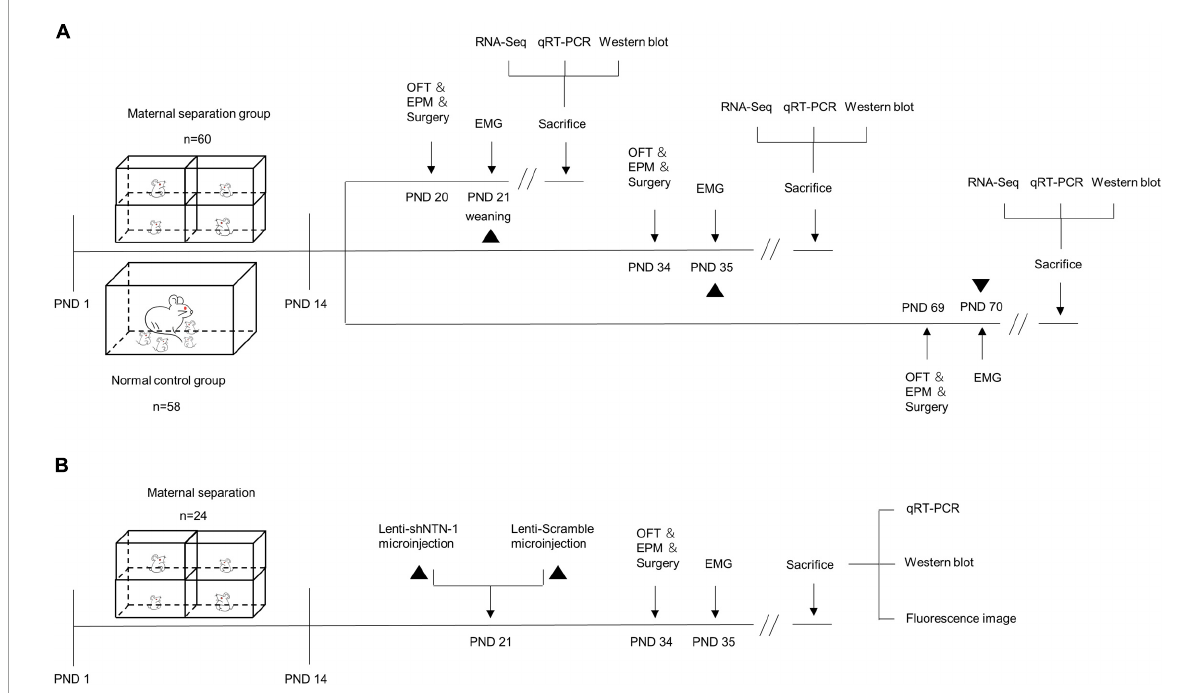
FIGURE1 The schematic of experimental procedures. (A) Maternal separation (MS) procedures were established on postnatal day (PND) 1–14 ( n = 60), and the normal control (NC) rats remained undisturbed ( n = 58). MS and NC rats were randomly subdivided into PND21, PND35, and PND70 groups. The open-field test (OFT), elevated plus maze (EPM) test, and surgery were performed a day before electromyogram (EMG) recording. The visceromotor response (VMR) to colorectal distension (CRD) was recorded by EMG on PND21, PND35, and PND70. After visceral sensitivity was measured, the rats were sacrificed and the hippocampus were dissected for RNA-Seq, quantitative real-time PCR (qRT-PCR), and Western blot. (B) MS procedures were established on PND 1–14 ( n = 24). On PND 21, rats were randomly assigned into two groups and were subjected to anti-Netrin-1 shRNA (Lenti-shNTN-1) or scrambled control shRNA (Lenti-Scramble) microinjection into the CA1 regions of the hippocampus. EMG was recorded on PND35, and the OFT, EPM, and surgery were performed a day in advance. After visceral sensitivity was measured, rats were sacrificed and the hippocampus were dissected for qRT-PCR and Western blot. The accuracy of injection sites was confirmed by fluorescence